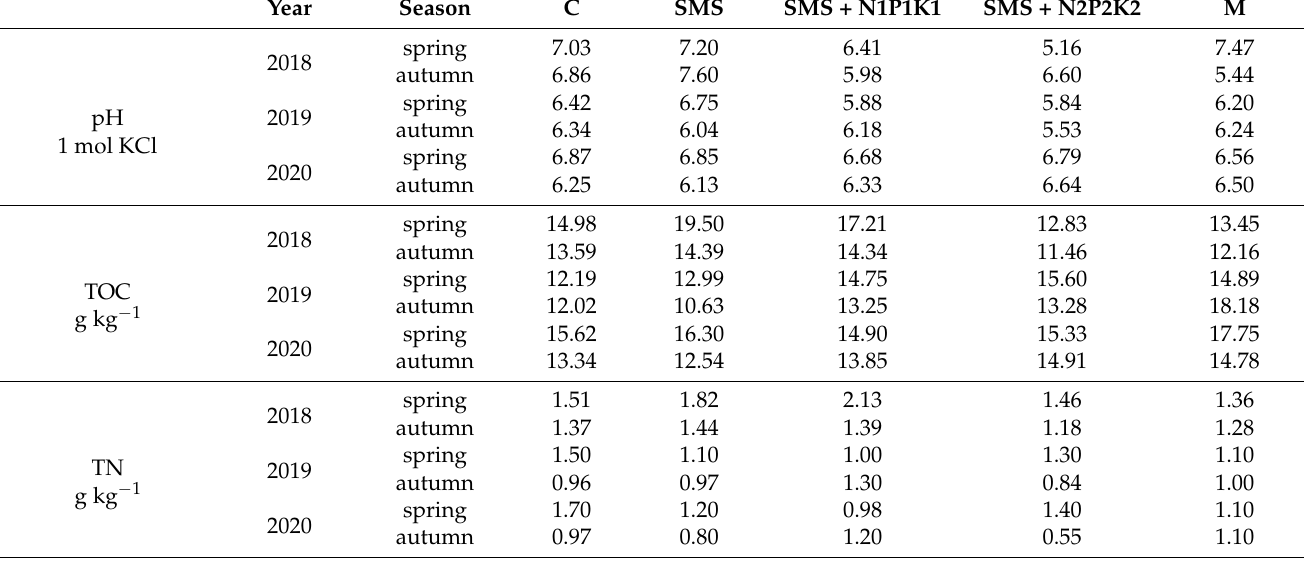
Table 2. Selected physico-chemical and chemical properties of the soil